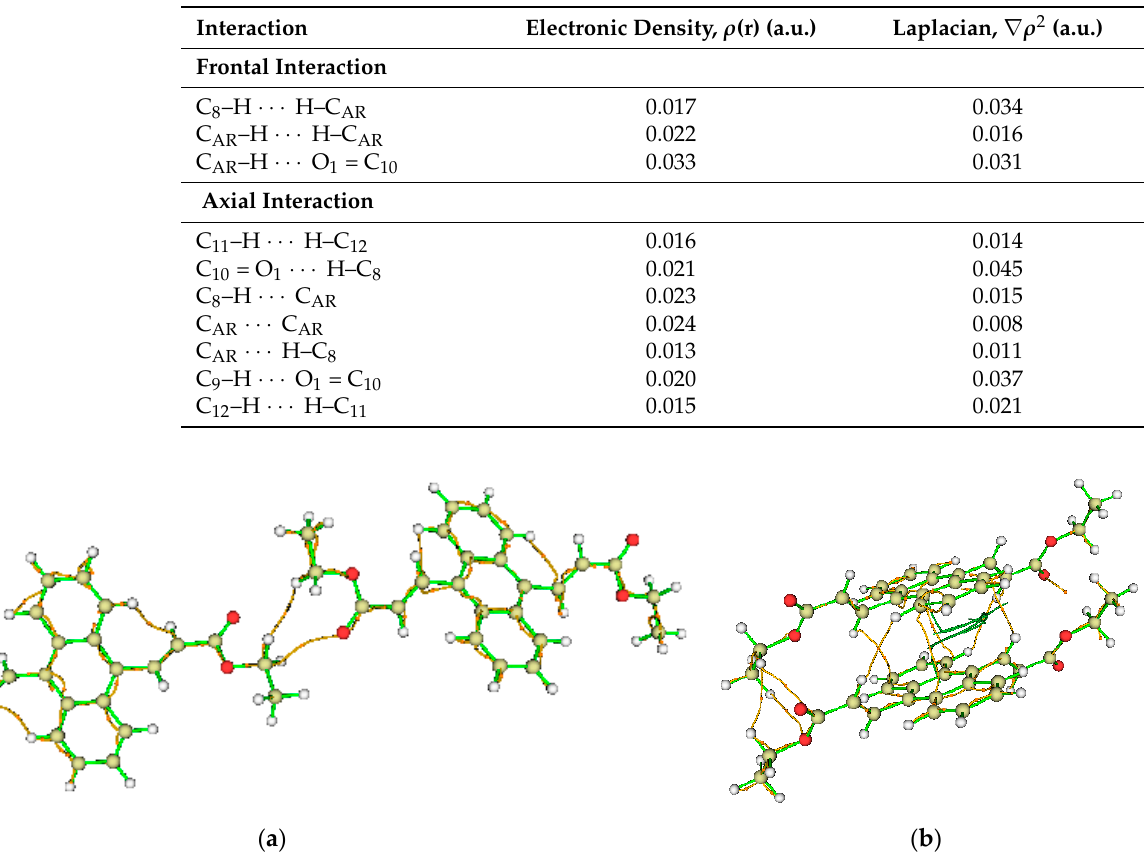
( b ) Figure 15. Molecular graph of the frontal ( a ) and axial ( b ) interactions between DEADP molecules in the crystals, where the orange lines correspond to the bond path, and the small orange circles to the bond critical point. 4. Conclusions Theoretical calculations showed that the geometric parameters obtained for the molecules of the studied compounds differ significantly, only in the C 8 and C 9 atoms. The differences only occurred due to the change in their hybridizations, as was in fact expected. The different groups, aromatic and aliphatic, configure flat structures; however, both molecular structures do not. Theoretical data showed that both compounds have electronically stable molecules, and DADB is chemically more reactive than DEADP due to the presence of the double bond in their acrylate groups. The molecules of both compounds are weakly complexed in the formation of their respective crystals, so that the donor orbitals and acceptor orbitals hyperconjugate with very low second-order energy. In addition, it was possible to show that the electronic charge density in the regions where the interactions occur is of the closed-shell type, configuring a low-intensity intermolecular contact.